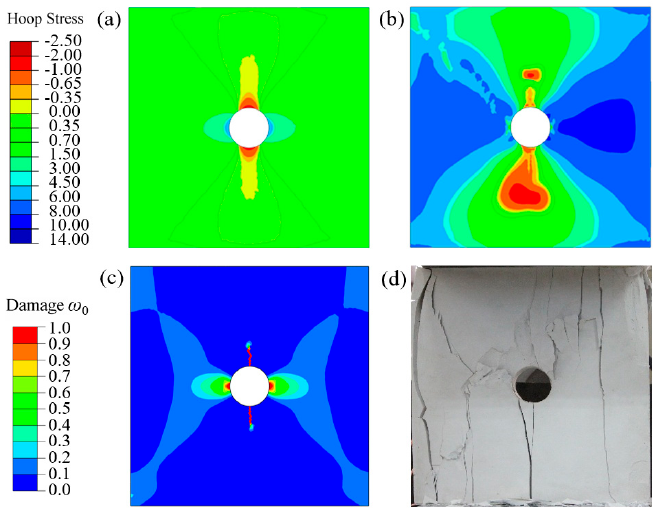
Figure 19. Hoop stress σ θ and damage ω 0 in specimen HA: ( a ) σ θ at σ 1 = 1 MPa, ( b ) σ θ at σ 1 = σ p , ( c ) ω 0 at σ 1 = σ p , and ( d ) fractures observed in the experiment.